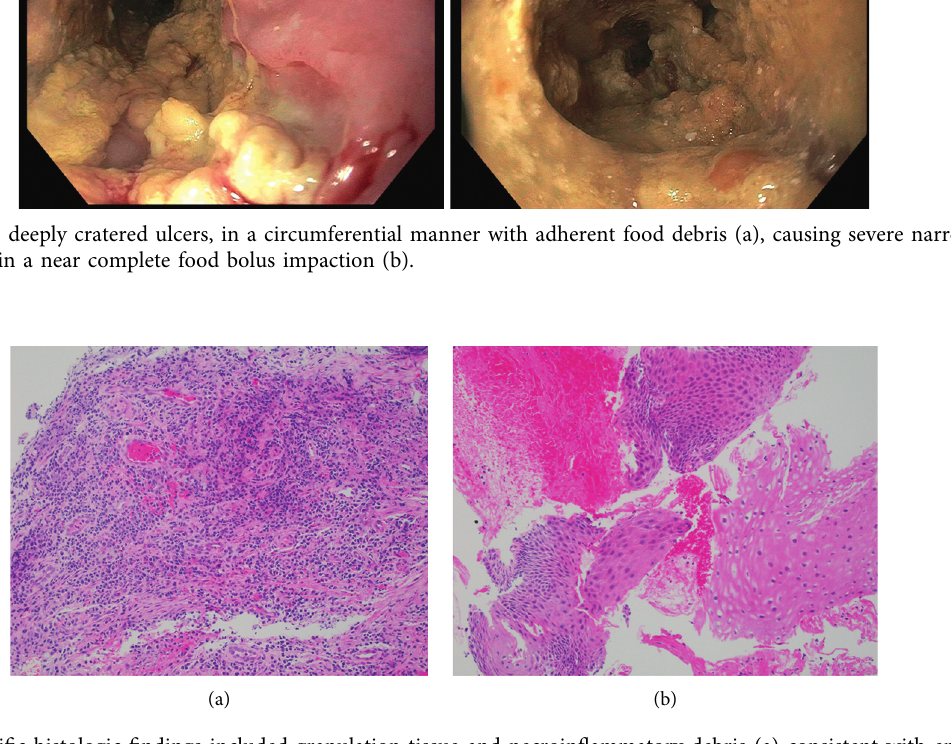
Figure 3: Nonspecific histologic findings included granulation tissue and necroinflammatory debris (a) consistent with endoscopically identified ulcer. Fragments of squamous epithelium showed reactive features (basal cell hyperplasia and balloon cell change)